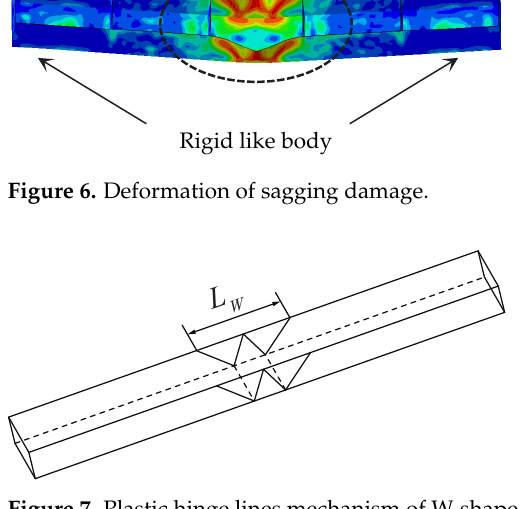
Figure 7. Plastic hinge lines mechanism of W-shaped